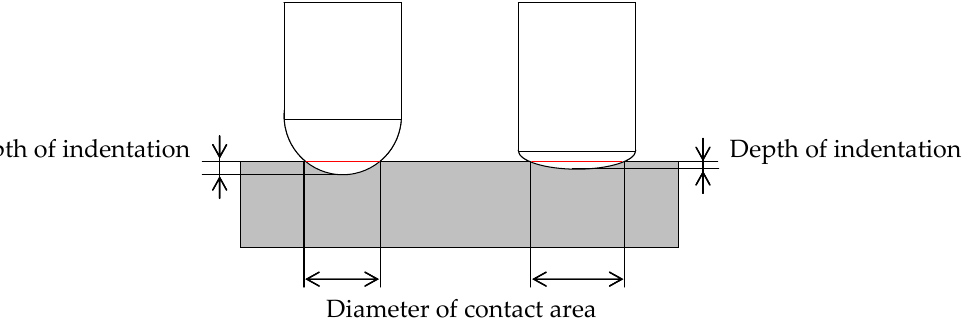
Figure 7. Schematics of contact area. Table 3. Diameter of contact area and depth of indentation.